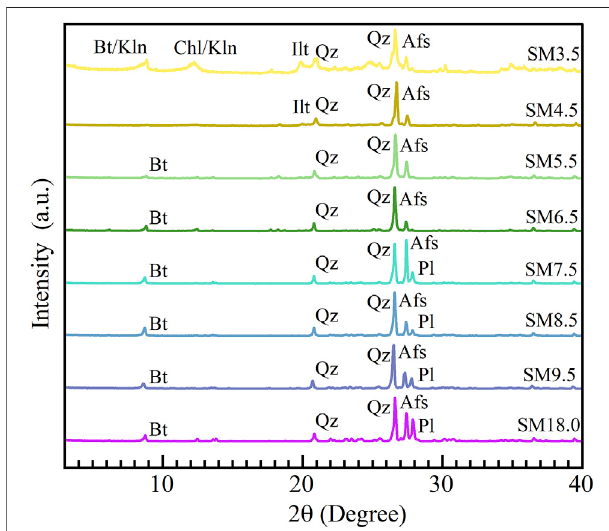
FIGURE6| ComparisonofXRDspectraofinsituchemicalweatheringof eight samples from the Sanming drill hole. Bt: Biotite, Chl: Chlorite, Kln: Kaolinite, Ilt: Illite, Qz: Quartz, Afs: Alkali feldspar, Pl: Plagioclase (Warr, 2021).